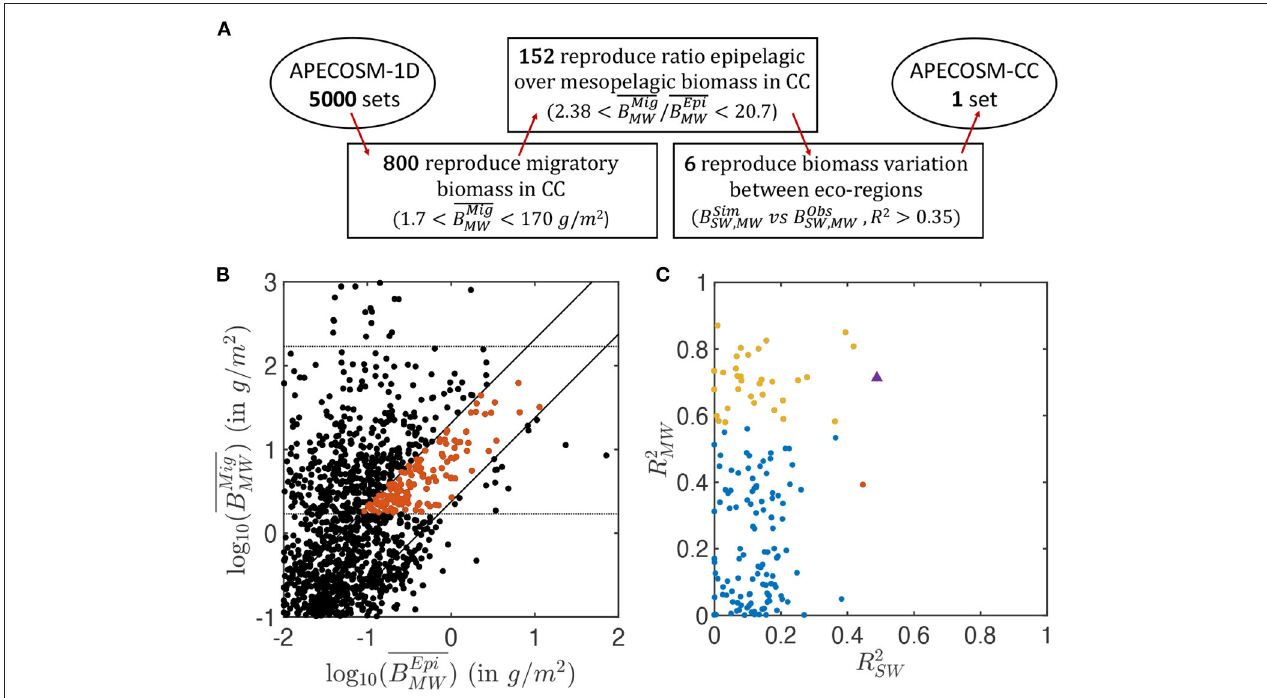
FIGURE 4 | Summary of the ensemble of simulations with APECOSM-1D. (A) Schematic of the steps used to identify the optimal parameter sets. (B) Average migratory biomass density ( B Mig MW ) as a function of average epipelagic biomass density ( B Epi MW ). (C) Coefficient of determination of the correlation between observed and simulated B Epi SW , B Mig MW , in the 15 eco-regions, for the best ensembles shown in red in (B) . In (B) , the dotted horizontal lines show the acceptable range for migratory biomass densities. The solid diagonal lines show the limits of acceptable migratory to epipelagic biomass ratio based on observations (between 2.38 and 20.7). In (C) , the red and yellow dots corresponds to ensembles for which epipelagic and mesopelagic biomass respectively correlate significantly with observations ( p < 0.05) (note that there is only one red dot). Blue dots are ensembles for which there is no statistically significant correlation between simulations and observation. The purple triangle corresponds to the final best set of parameters selected for the 3D APECOSM-CC dynamic